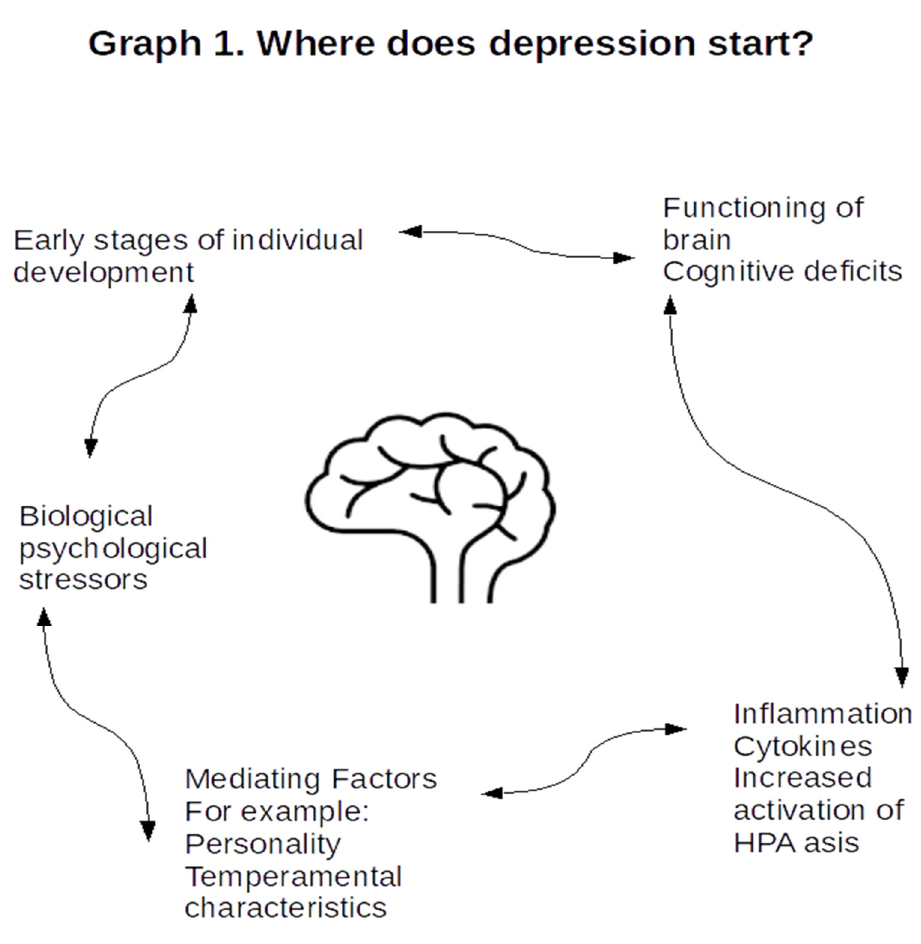
Figure 1. Possible multifactorial interactions, worth further investigation.